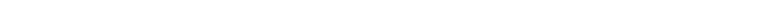
Figure 2. BEL+T DIAgram v2.0 complete (Source: Tregloan et al., 2021)